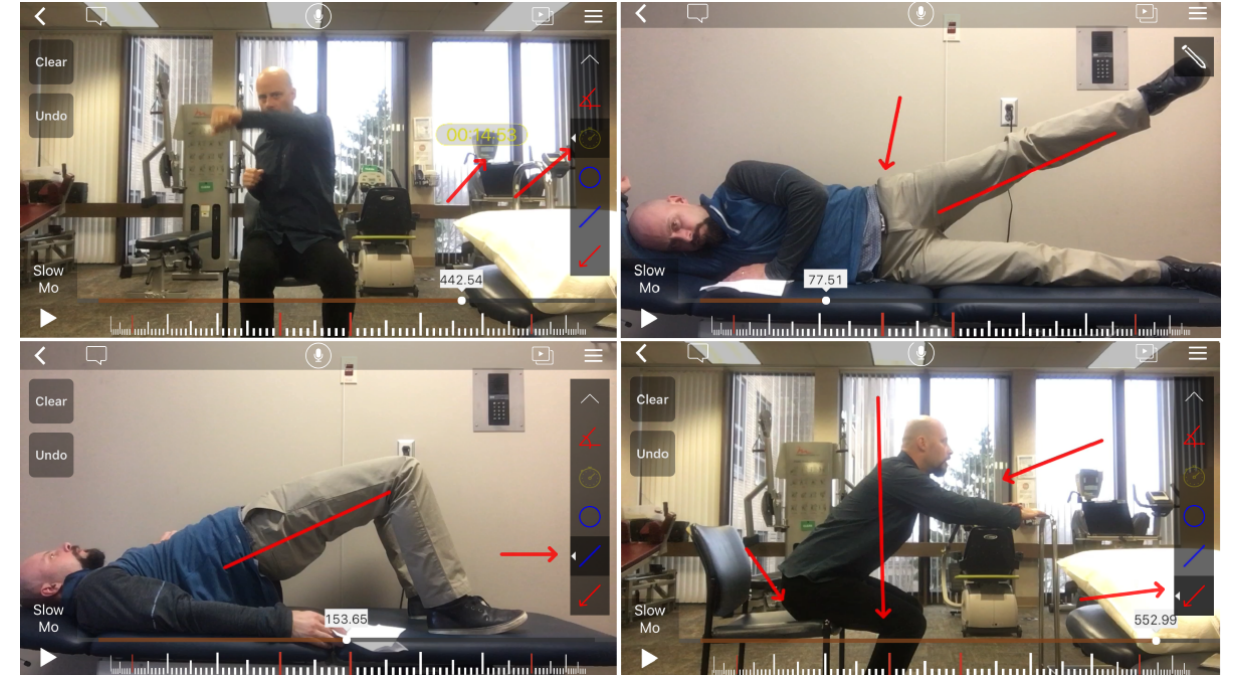
Figure 1. Examples of Hudl app video captures of the telehealth physical therapist’s home exercise program. The telehealth physical therapist used the tools displayed on the right-hand side of the screen (arrows, plumb line, chronometer, etc) to highlight the parts that participants needed to pay attention